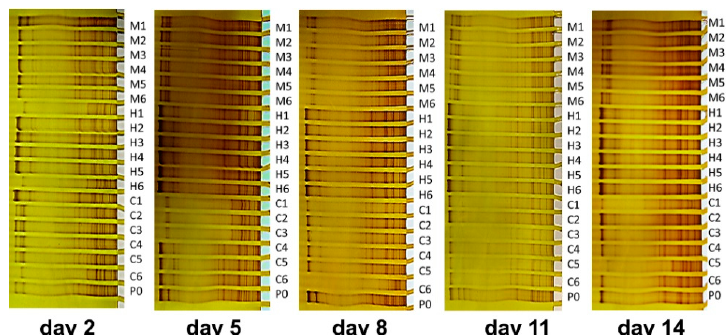
Figure 4. SSCP fingerprints of pioneer bacterial communities in the natural biofilms developed on different PDMS-based composite surfaces with different exposure times.